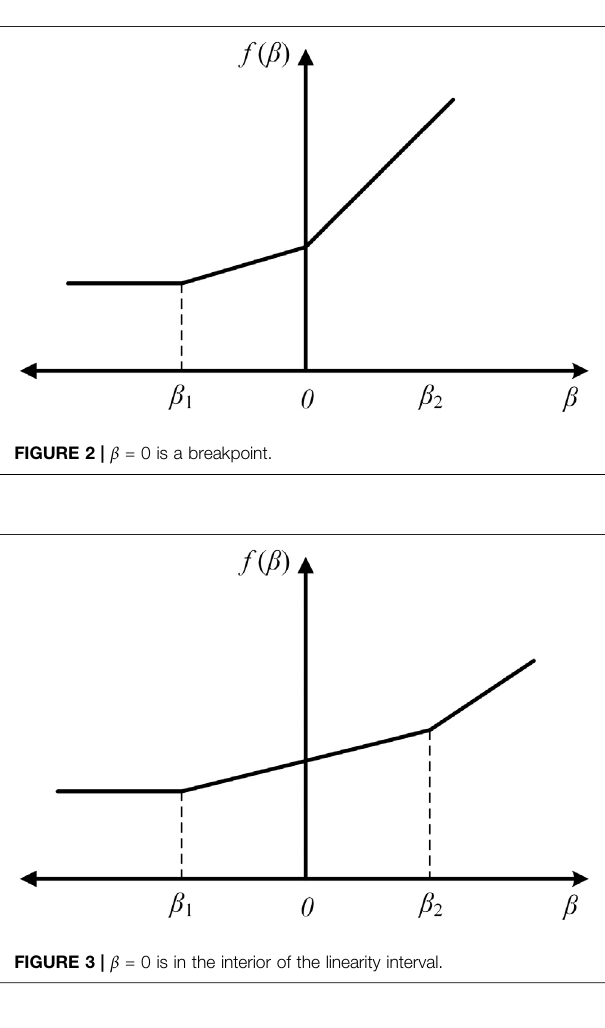
Step 1: Initialization. Input power system data, load level data, PV and WT output data. Set the maximum contingency order.